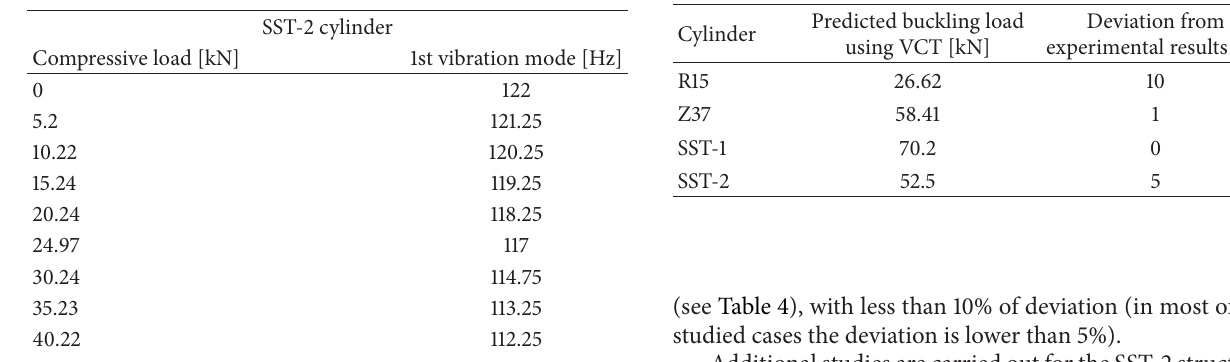
Table 8: Buckling load prediction using the VCT approach for the different studied